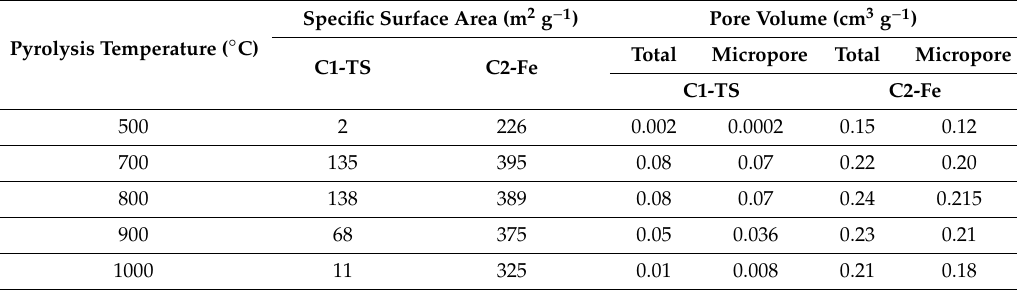
Table 3. Structural parameters calculated from nitrogen physisorption isotherms.